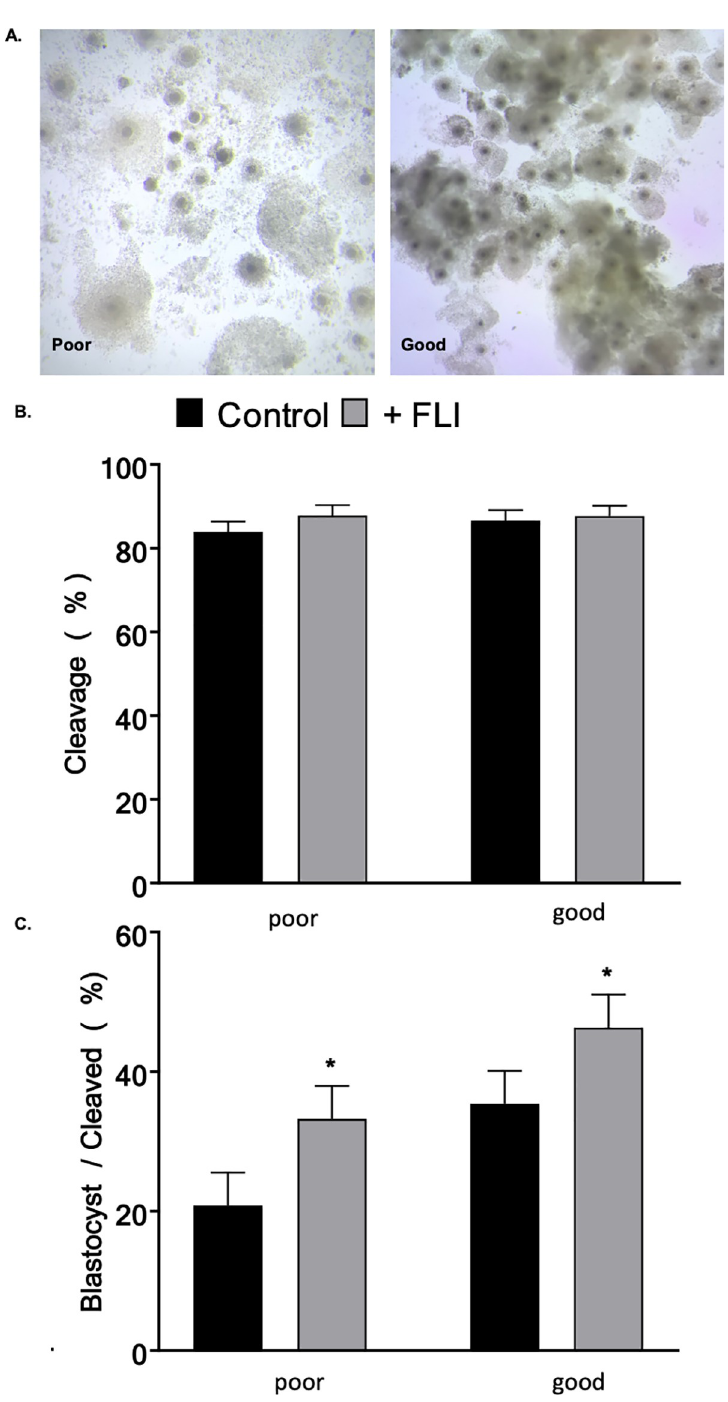
Fig 3. FLI Supplementation to culture medium improves embryo development. Bovine oocytes (n = 1,066) were of different qualities. (A) Example of oocytes classified as poor quality (470) or good quality (596) (B) Proportion of zygotes that underwent at least one cellular division. (C) The extent of the effect of FLI supplementation in culture medium on development to blastocyst stage varies based on oocyte quality/source. Asterisk ( � ) indicates statistical differences ( P < 0.05). Values are LSMEANS ±